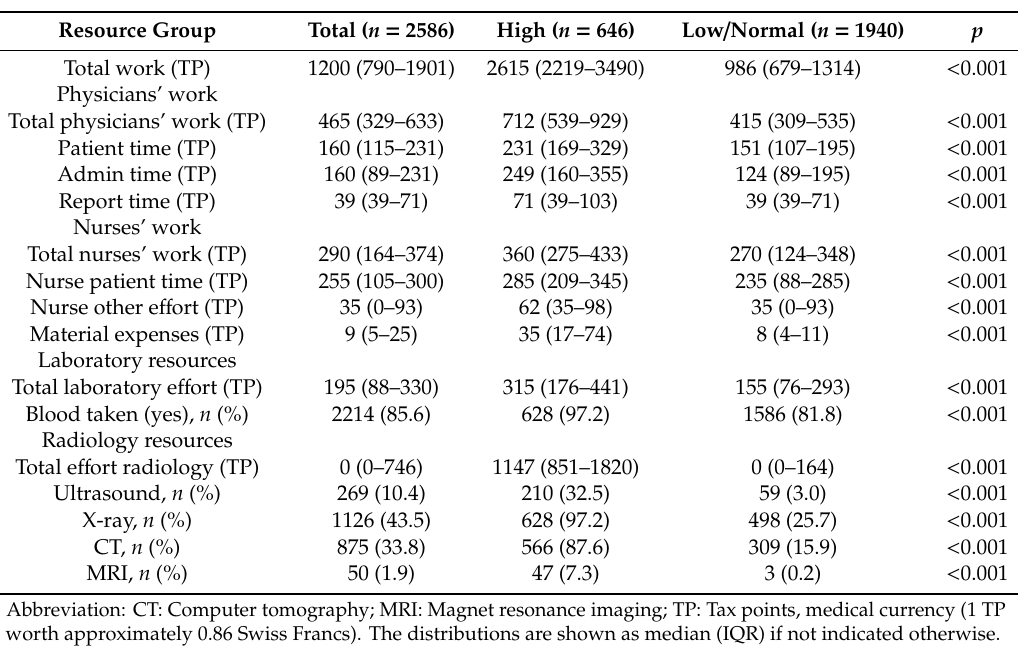
Table 2. Resource consumption of alcohol-intoxicated consultations ( n = 2586).